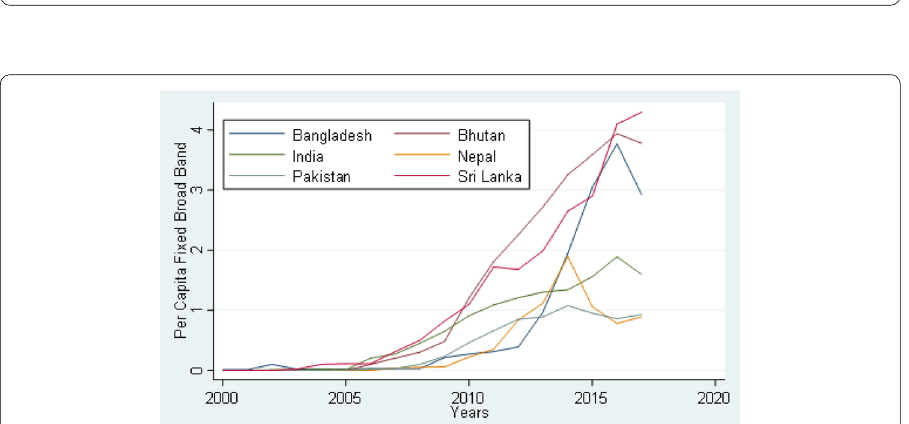
Fig. 2 Per capita fixed broadband (source: World Development Indicators